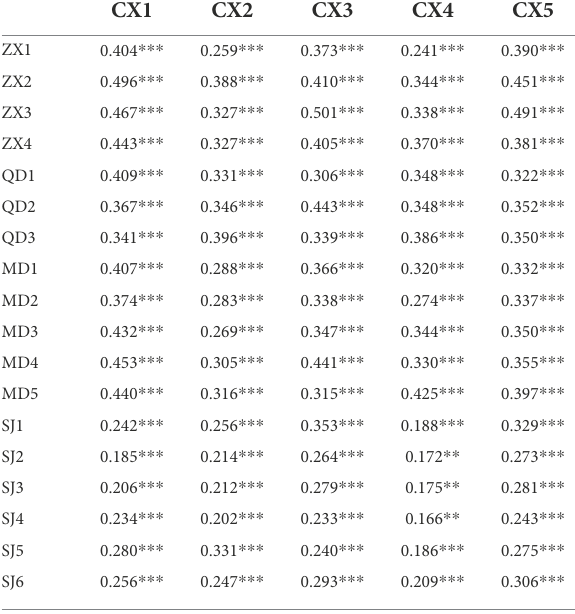
TABLE 7 Correlation analysis of observation